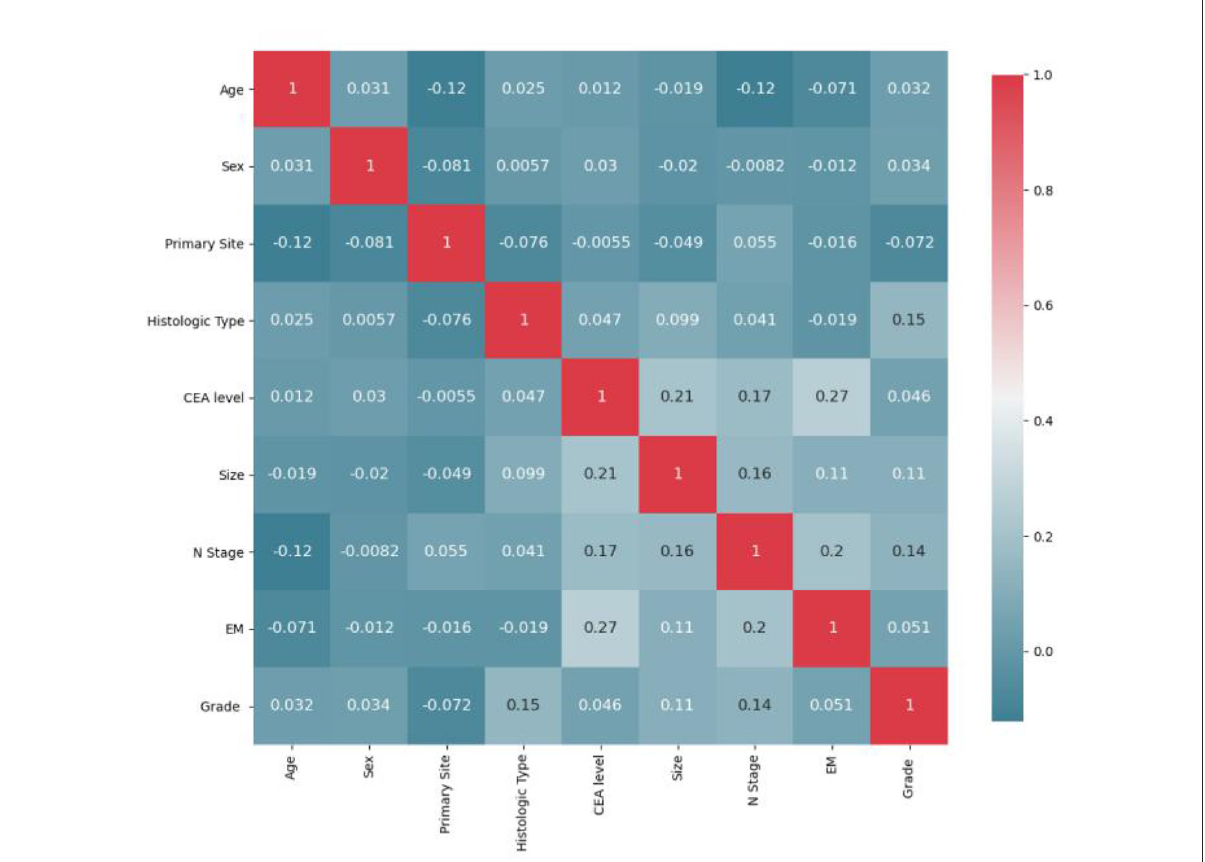
FIGURE6 Results of Pearson correlation analysis between all variables. The heatmap shows the correlation between the variables.